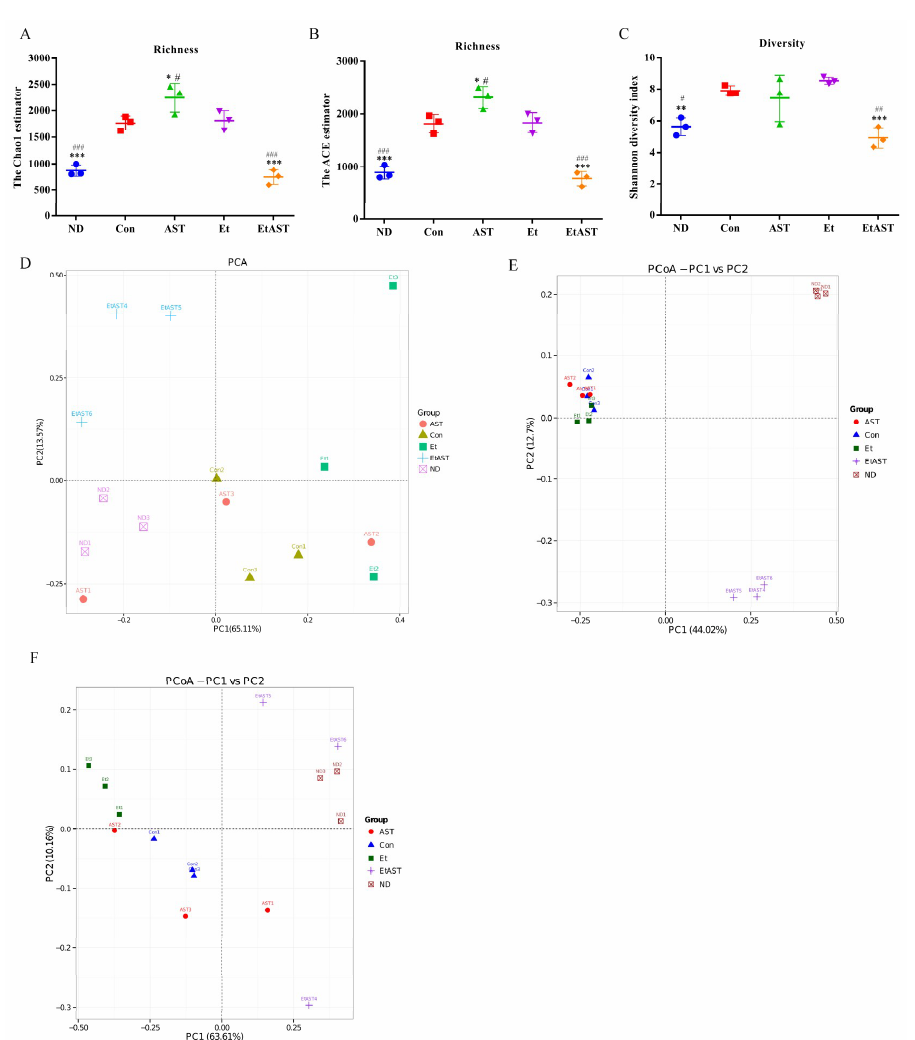
Figure 3. Astaxanthin treatment ameliorates the microbiota profiles affected by the ethanol diet. Bacterial genomic DNA was extracted from the feces collected at the end of week 12, and 16S rDNA sequence analysis was performed. Alpha diversity analysis, the Chao1 estimator ( A ), the ACE estimator ( B ), and the Shannon diversity index ( C ) were used for evaluation. To investigate the similarity of gut microbial community structure among different samples, we conducted beta-diversity analysis and PCA analysis ( D ), PCoA score plot based on unweighted UniFrac ( E ), and weighted UniFrac ( F ). ND: normal diet; Con: high-fat diet with 35% of total calories from fat; AST: high-fat diet + astaxanthin; Et: Lieber–DeCarli liquid ethanol diet with 35% of total calories from fat; EtAST: Lieber–DeCarli liquid ethanol diet with 35% of total calories from fat + astaxanthin. # represents p < 0.05, ## represents p < 0.01, and ### represents p < 0.001 compared with the Con group, * represents p < 0.05, ** represents p < 0.01, and *** represents p < 0.001 compared with the Et group.